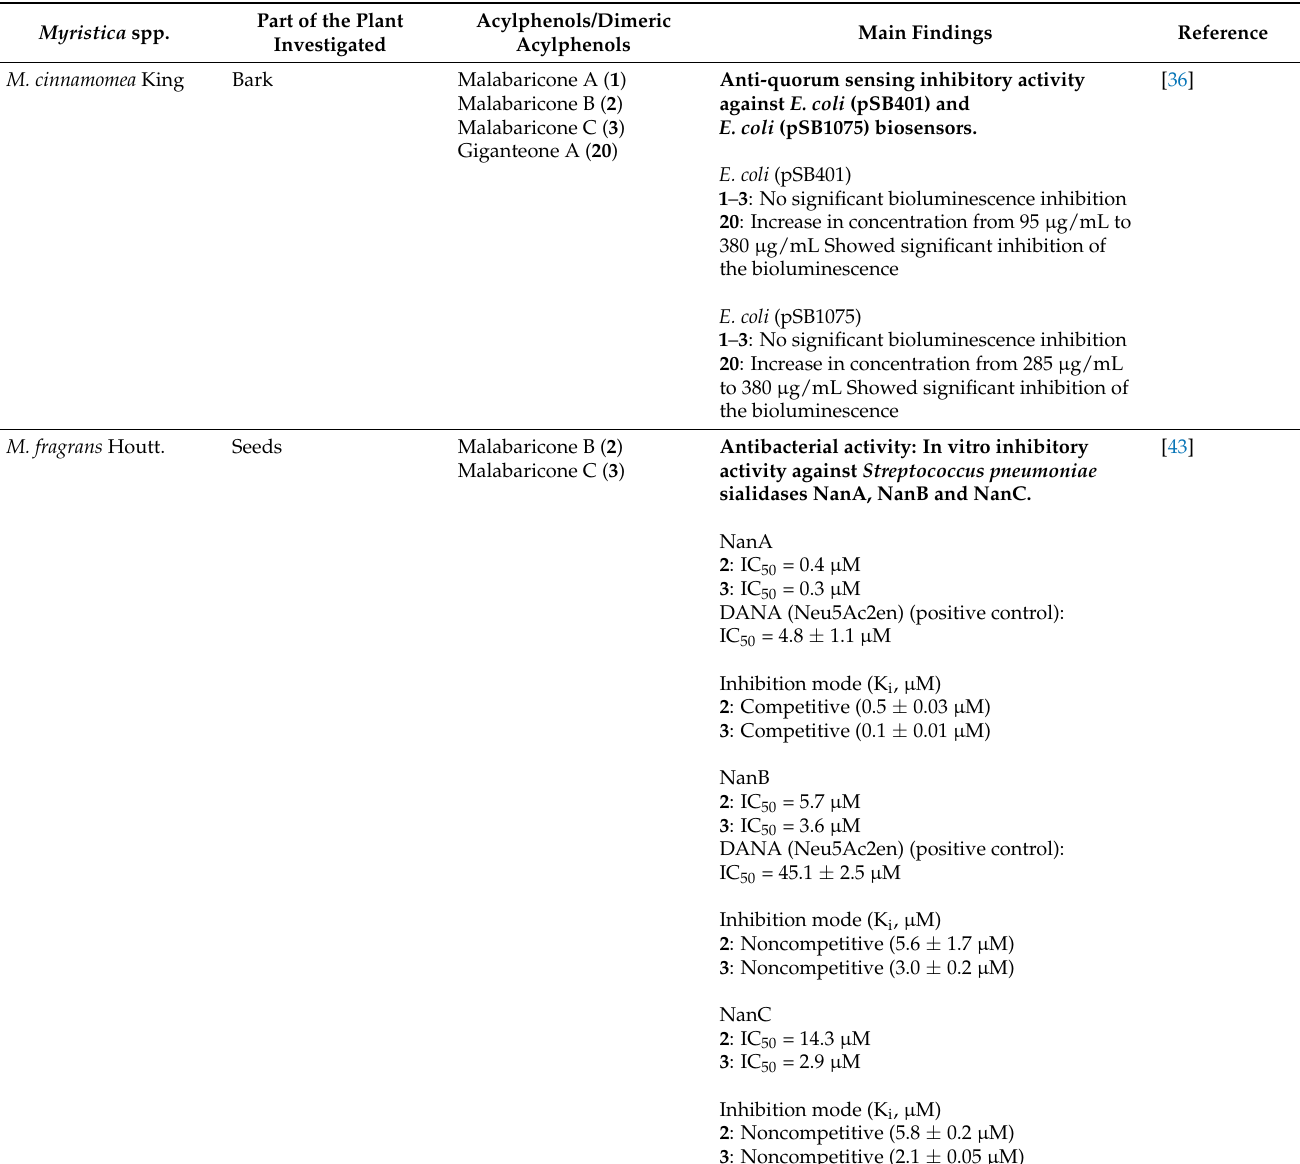
Table 6. The antibacterial and anti-quorum sensing activities of acylphenols and dimeric acylphenols from the genus Myristica